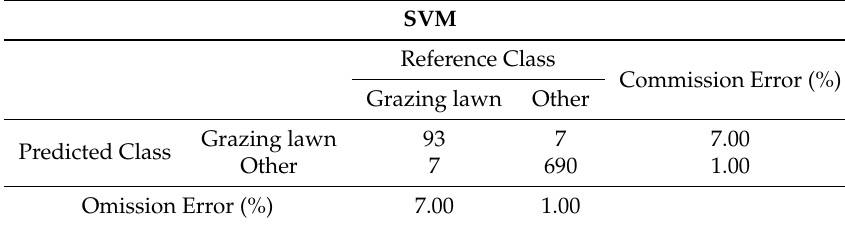
Table A3. Confusion matrix summarising results from Support Vector Machines (SVM) model classification of grazing lawn and other